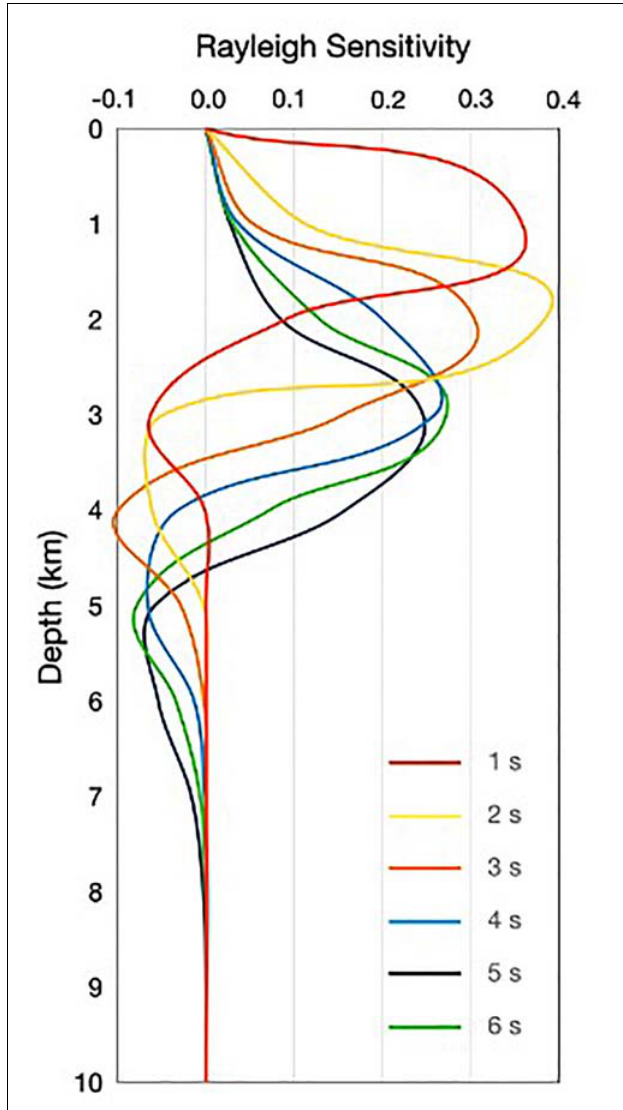
FIGURE 8 | Sensitivity kernels for group velocity of Rayleigh wave corresponding to the shear wave velocity model, computed using the code from Herrmann (2013) at periods of 1–6 s each indicated by different